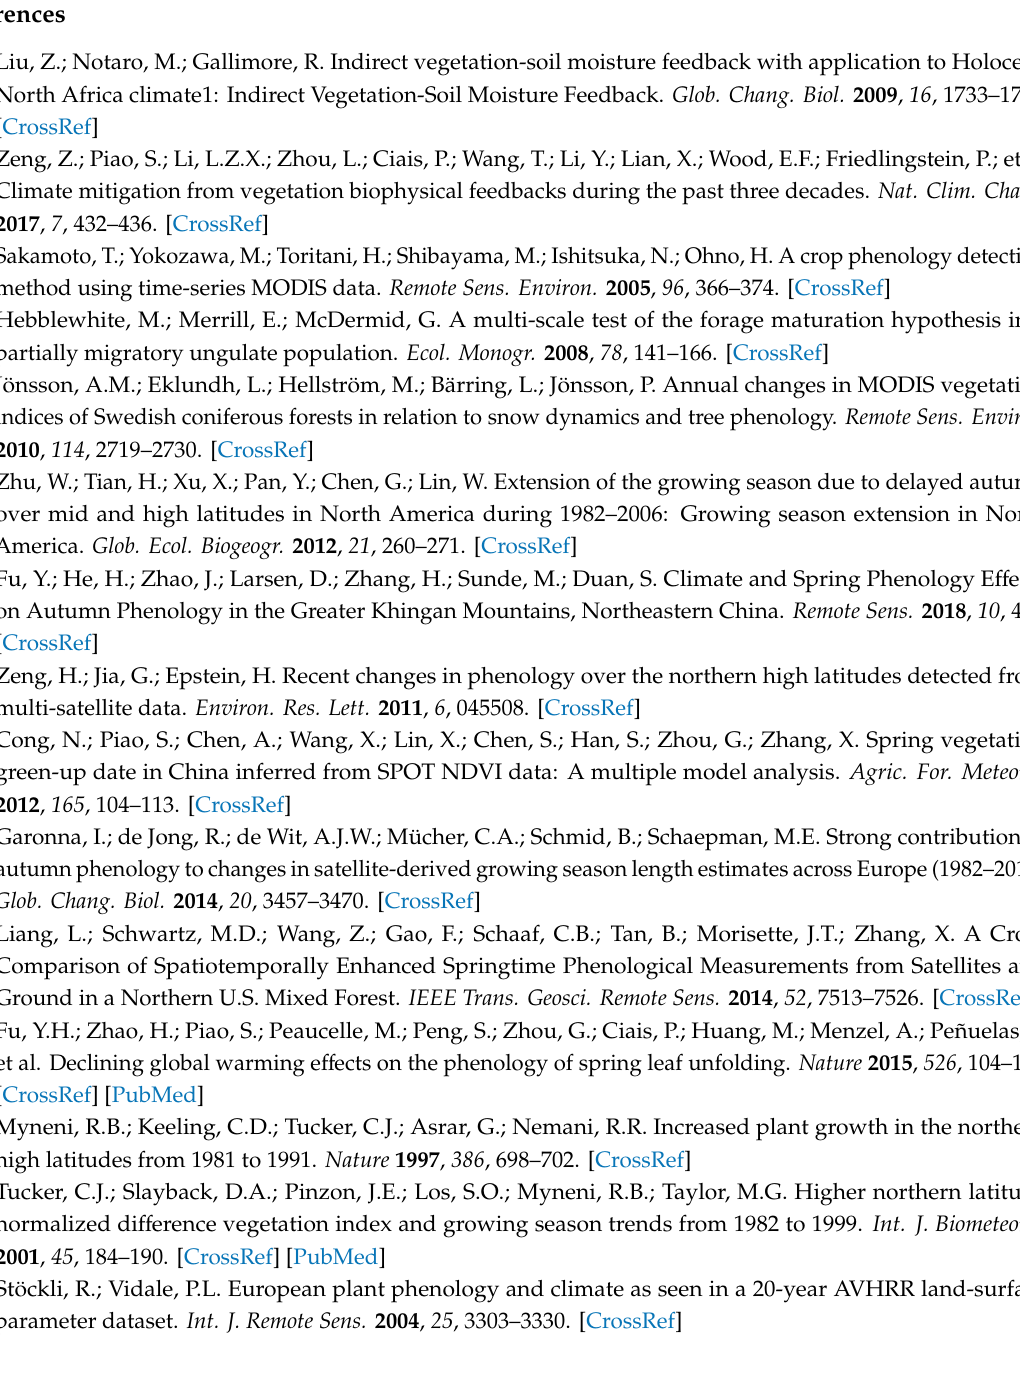
types, Figure S5: Trends and temporal variations in the SOS for di ff erent vegetation types in the boreal forest during